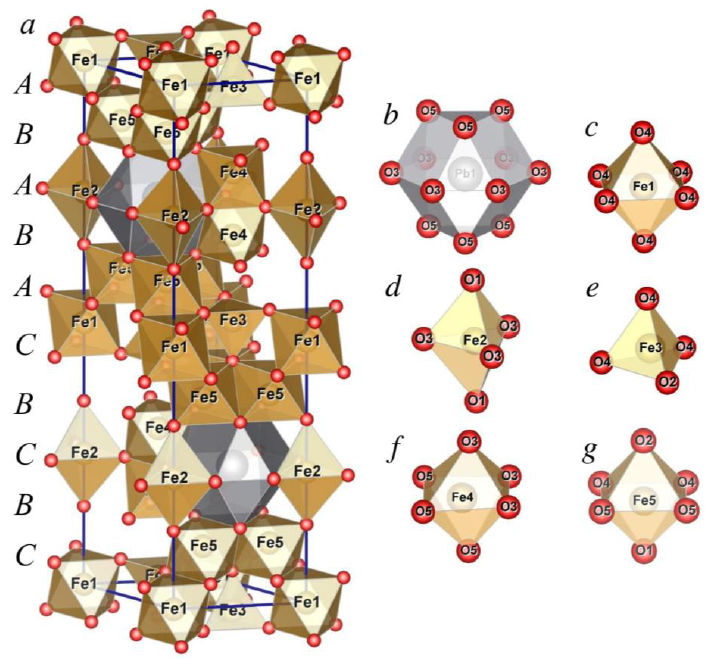
Figure 1. The unit cell of PbFe 12 O 19 ( a ) and the coordination polyhedra of the cations Pb 2 + ( b ) and Fe 3 + ( c – g ). Nanomaterials 2020 , 10 , x